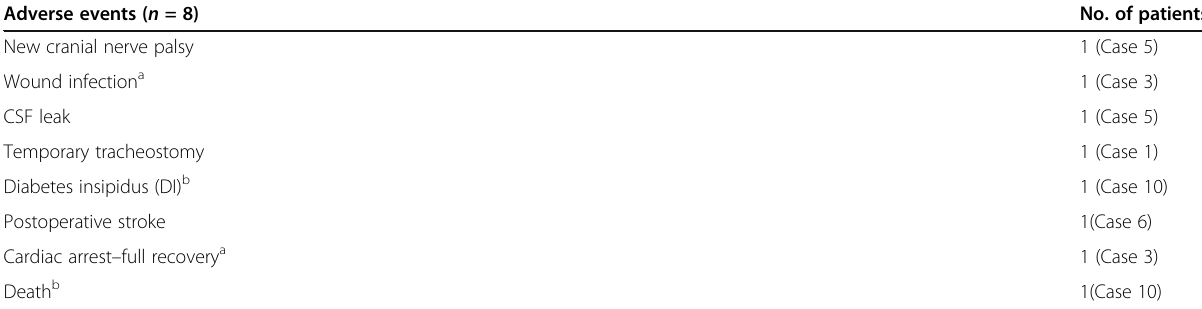
Table 4 Operative morbidity and mortality. CSF cerebrospinal fluid, No.